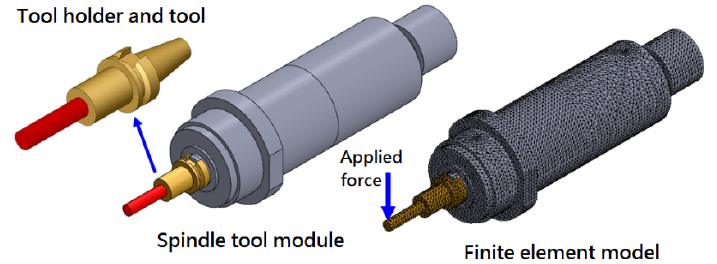
Figure 3. Solid model and finite element model of spindle unit.